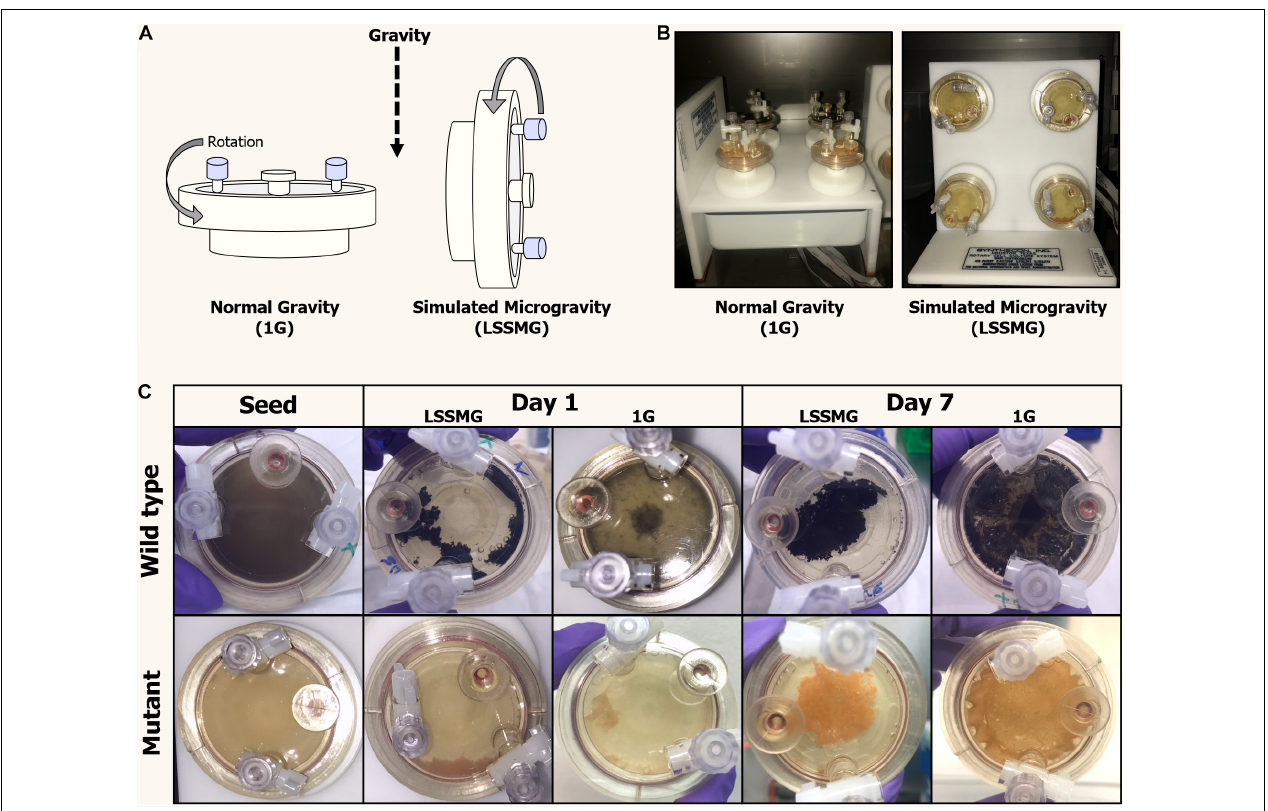
FIGURE 1 | Rotary Cell Culture System (RCCSTM, Synthecon) and High Aspect Ratio Vessels (HARVs) used in the LSSMG experiments. (A) Schematic diagram of mechanical principle of the different RCCSs (design: Emily Klonicki). In normal gravity, the vessels (HARVs) rotate around a plane parallel to the gravity vector. Microgravity is simulated by rotating the samples around a plane perpendicular to the gravity vector. (B) The RCCS used to generate 1G condition (control) on ground (left); the RCCS used to generate LSSMG condition on ground (right); (C) Colony and cultural features of Knufia chersonesos MA 5789 (wild type, Wt) and MA5790 (mutant, Mut) under LSSMG and 1G on the first and last day of cultivation. The HARVs provide oxygenation via a flat, silicon rubber gas transfer membrane located at the base of the vessel and directly underneath the